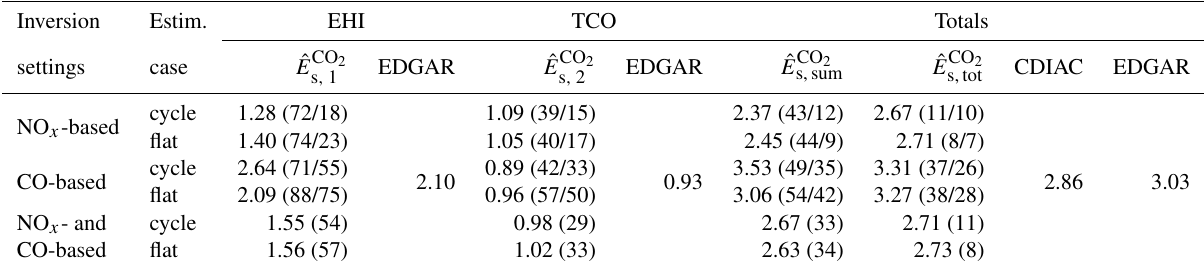
Table 3. The estimates of the fossil-fuel CO 2 emissions (PgCO 2 ) from the study region in comparison with corresponding data (when available) of the EDGAR v4.2 and CDIAC emission inventories. The numbers in brackets represent the one-sided 68.3% confidence intervals (in % relative to the respective optimal estimate). Along with the “full” confidence intervals, the “partial” confidence intervals are shown after a slash (except for the combined estimates) and do not include uncertainties in the conversion factors. Inversion Estim. EHI TCO